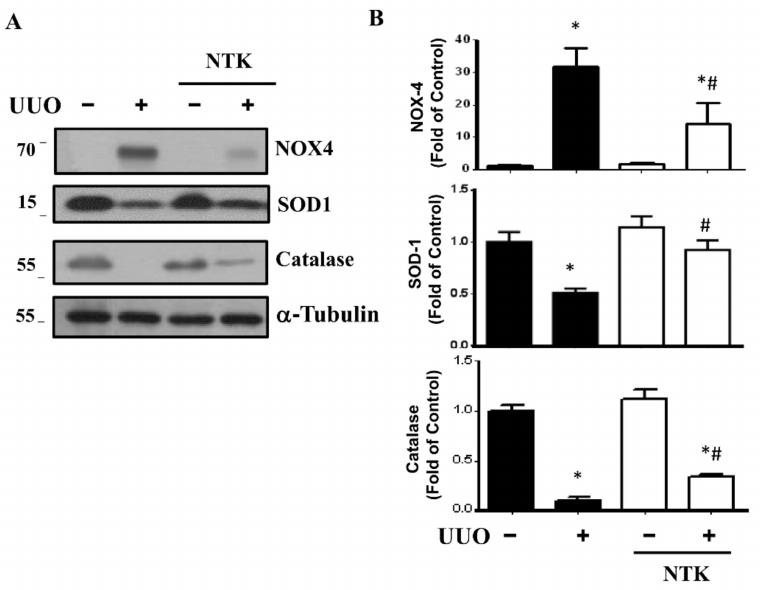
Figure 5. Effects of Nootkatone treatment on oxidative stress injury in the UUO kidneys. Vehicle or Nootkatone (NKT) was orally given to the sham or UUO mice for 14 days. Protein expression levels of the oxidative stress markers were determined by Western blotting ( A ). The quantification is shown in ( B ). Data are presented as mean ± SD ( n = 6). * p < 0.05 vs. the sham control group. # p < 0.05 vs. the UUO group.